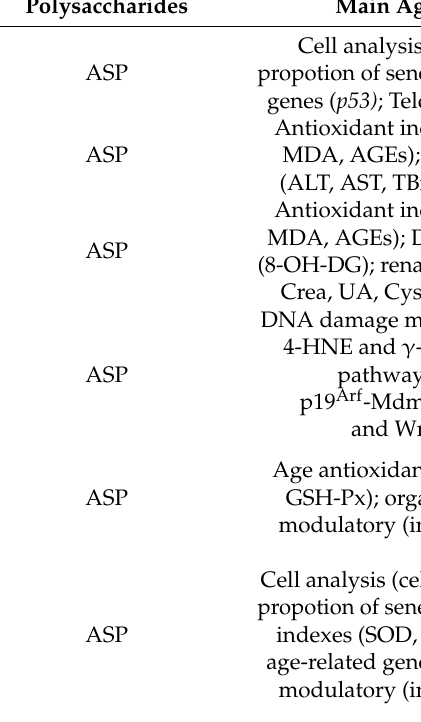
Table 3. Anti-aging study of polysaccharides using mice as a model. Polysaccharides Main Aging Indicators Mechanism